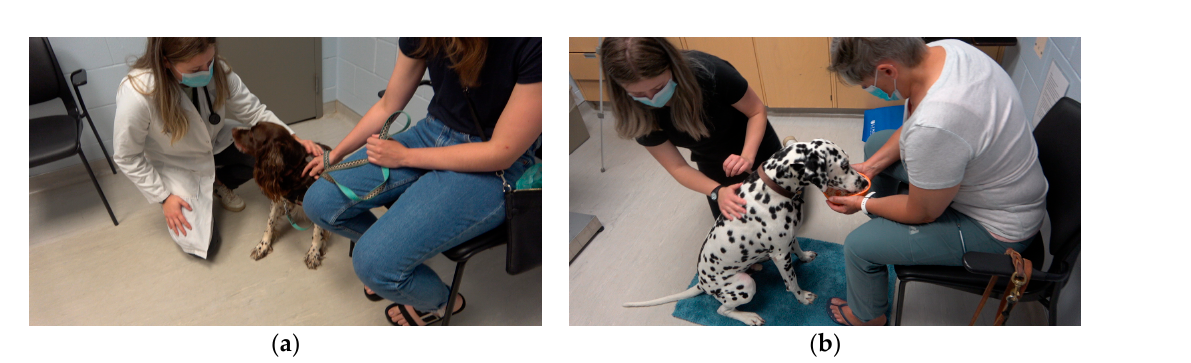
Figure 3. ( a ) Physical exam example for control group and ( b ) intervention group.